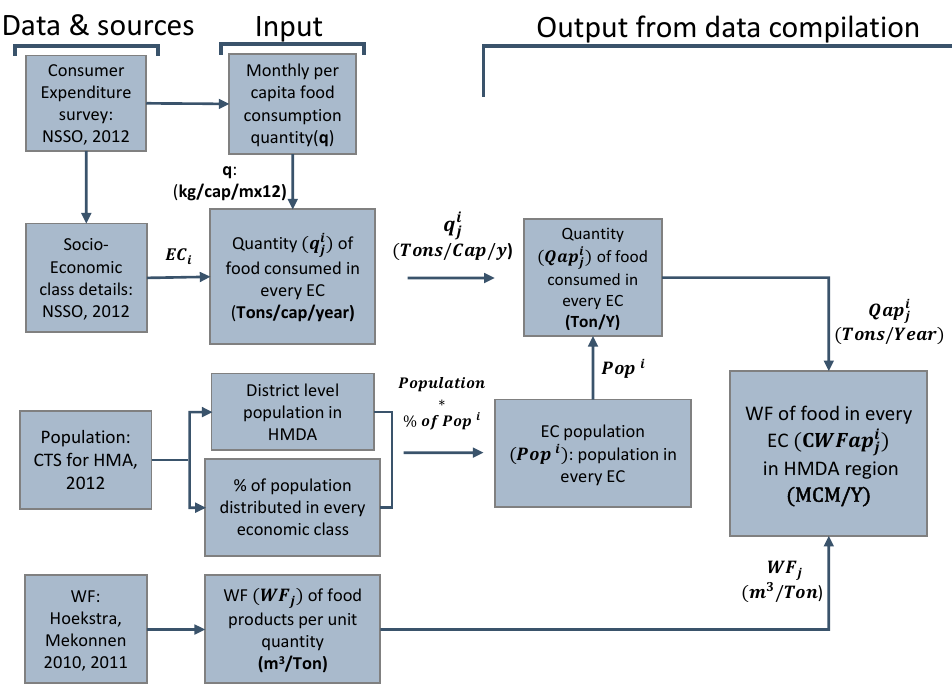
Figure 3. Calculation procedure to quantify embedded water content in food consumption for each food product and each economic class, and city-level embedded water contents in food consumption. EC: economic